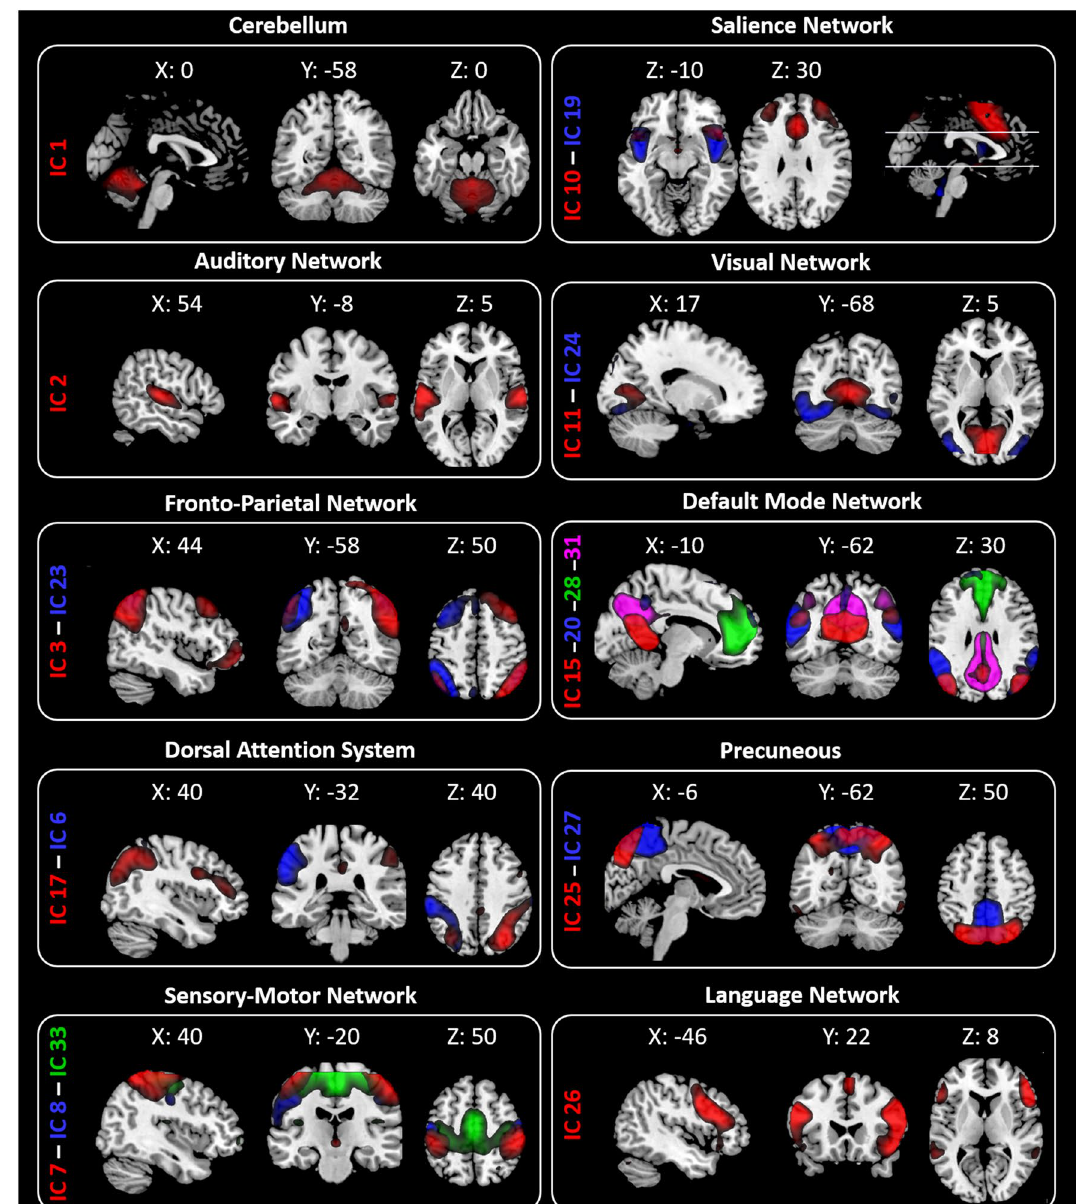
Figure 1. Resting State Networks (RSNs) identified by GIFT. Twenty spatial maps divided into ten functional networks were found: Cerebellum (Cb—IC1); Auditory (AN—IC2); Fronto-Parietal (FPN: IC3—rFPN and IC23—lFPN); Dorsal Attention System (DAS: IC6—lDAS and IC17—rDAS); Sensory Motor (SMN—IC7, IC8, IC33); Salience (SN—IC 10 and IC19); Visual (VN: IC11—Primary Visual and IC24—Lateral Visual); Default Mode (DMN—IC15, IC20, IC28 and IC31); Precuneous (IC25 and IC27) and Language (LN—IC 26) networks based on their anatomical view. Montreal Neurological Institute (MNI) coordinates are shown as